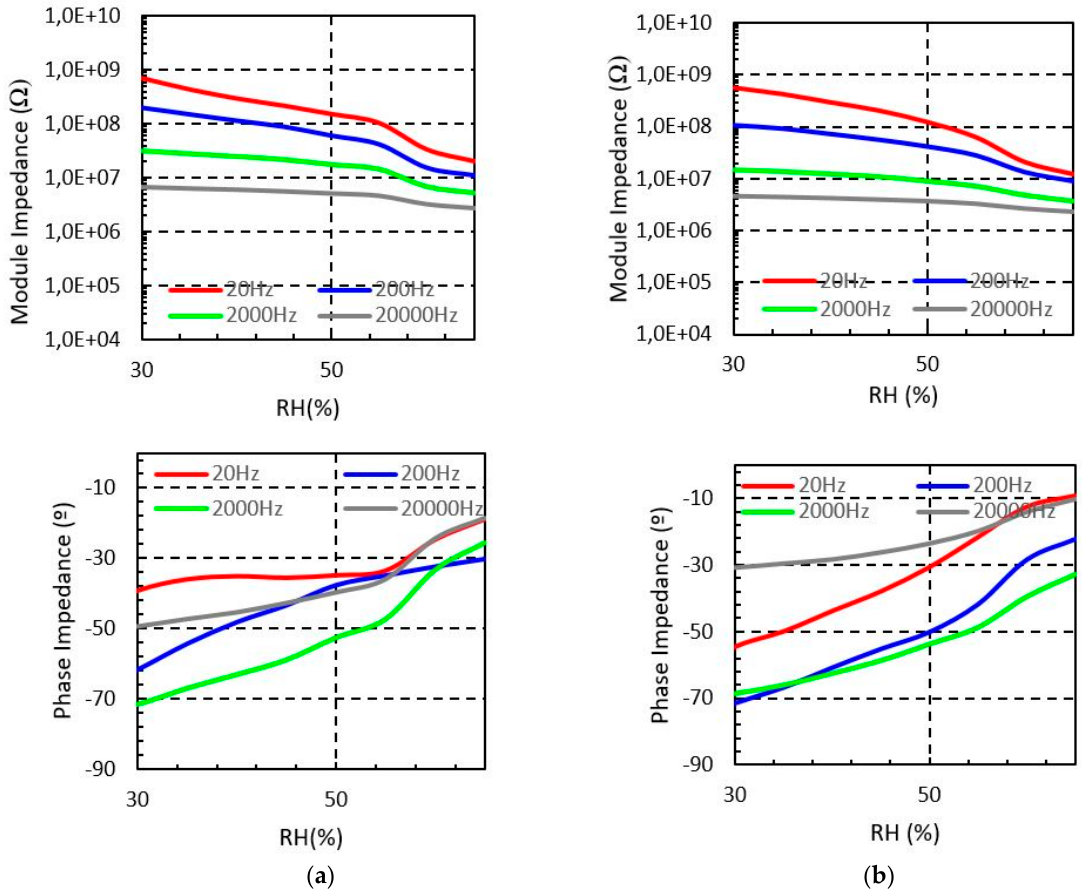
Figure 4. Measured Shieldex sensors impedance from 30% to 65% RH at different frequencies (T = 20°C). ( a ) Short sensor impedance ( b ) Long sensor impedance.